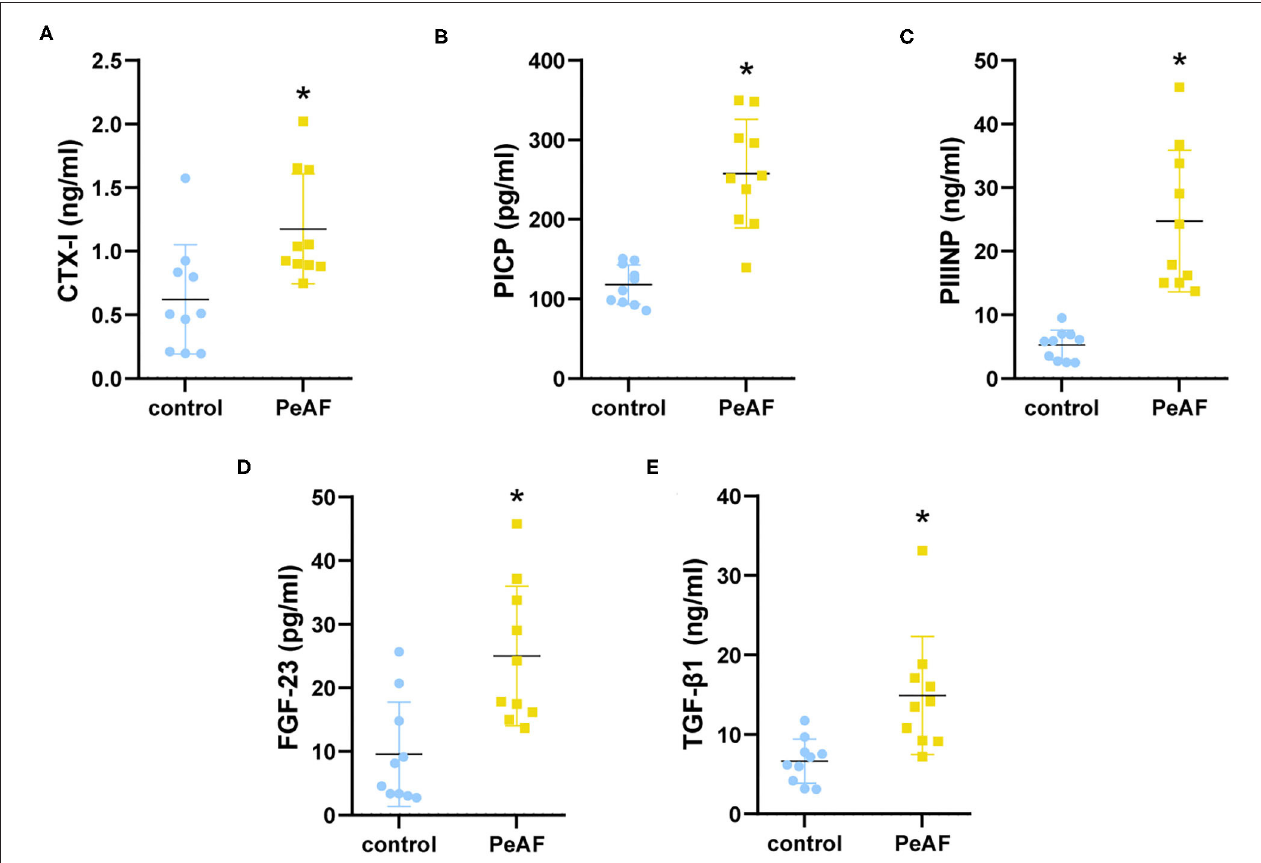
FIGURE 1 | Serum levels of myocardial fibrosis markers. (A) Levels of CTX-I in serum. (B) Levels of PICP in serum. (C) Levels of PIIINP in serum. (D) Levels of FGF-23 in serum. (E) Levels of TGF- β 1 in serum. (F) Levels of PIIINP in serum. * p < 0.05 vs. control group. CTX-I, carboxy-terminal telopeptide of type I collagen; PICP, propeptide of type I procollagen; PIIINP, procollagen III N-terminal propeptide; FGF-23, fibroblast growth factor-23; TGF- β 1, transforming growth factor-beta